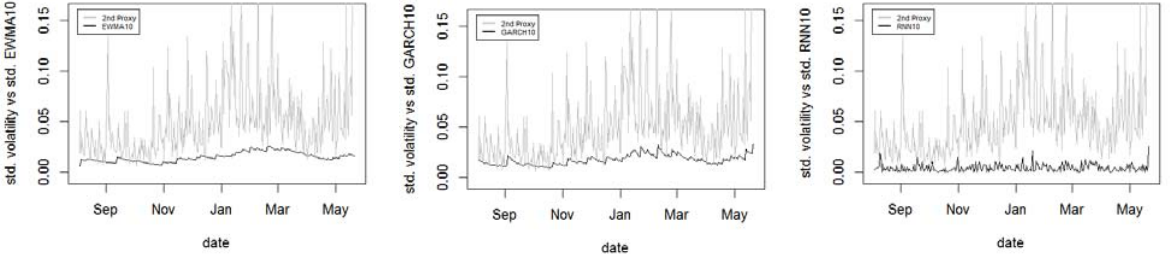
Figure 4. Out of sample standard deviation of realized volatility (2nd proxy) vs standard deviation of 10 days